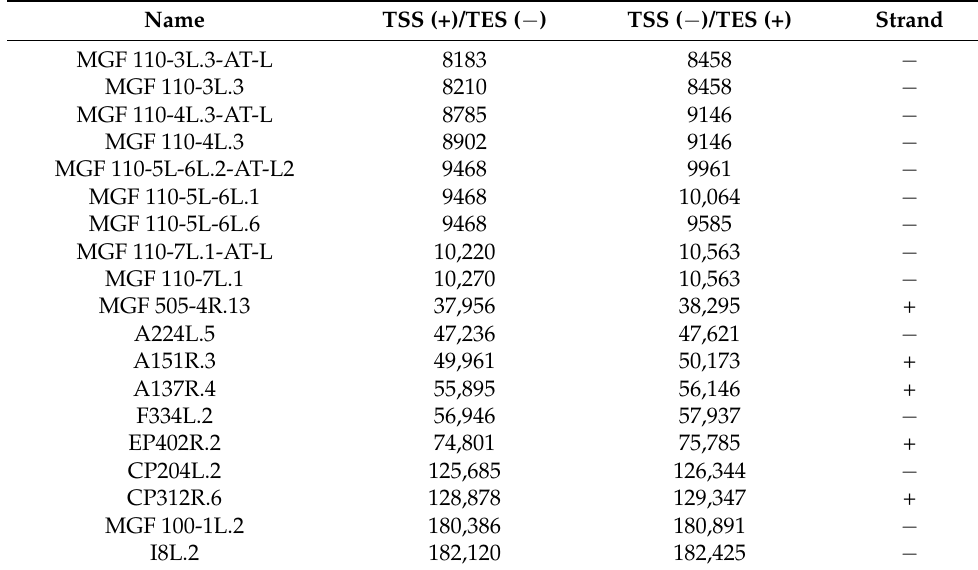
Table 2. List of the 5 (cid:48) truncated